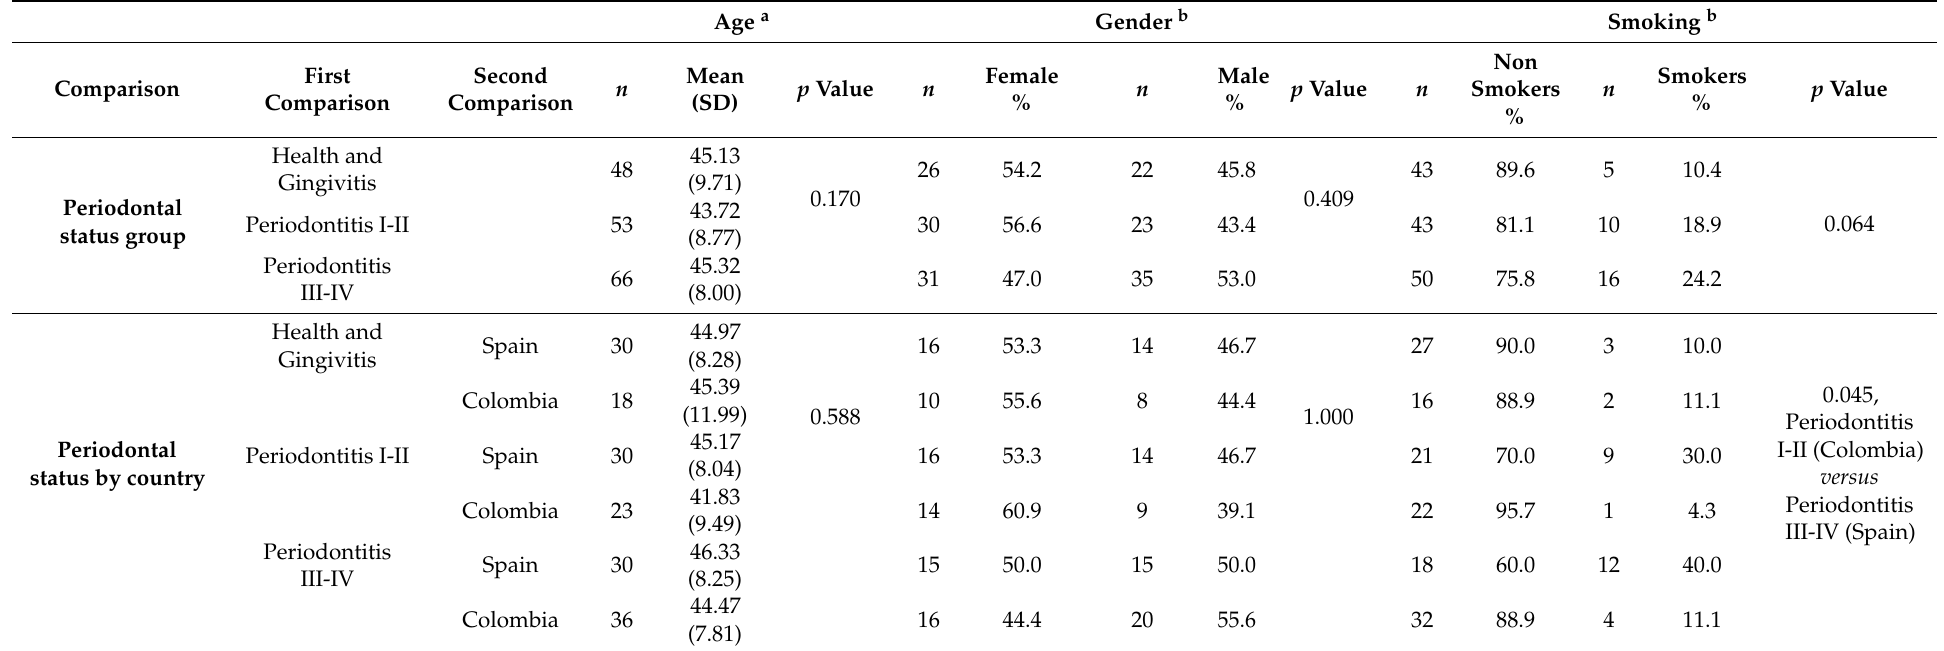
Table 2. Description of the sample population characteristics (demographic variables and smoking habit), and comparisons according to periodontal status and country.